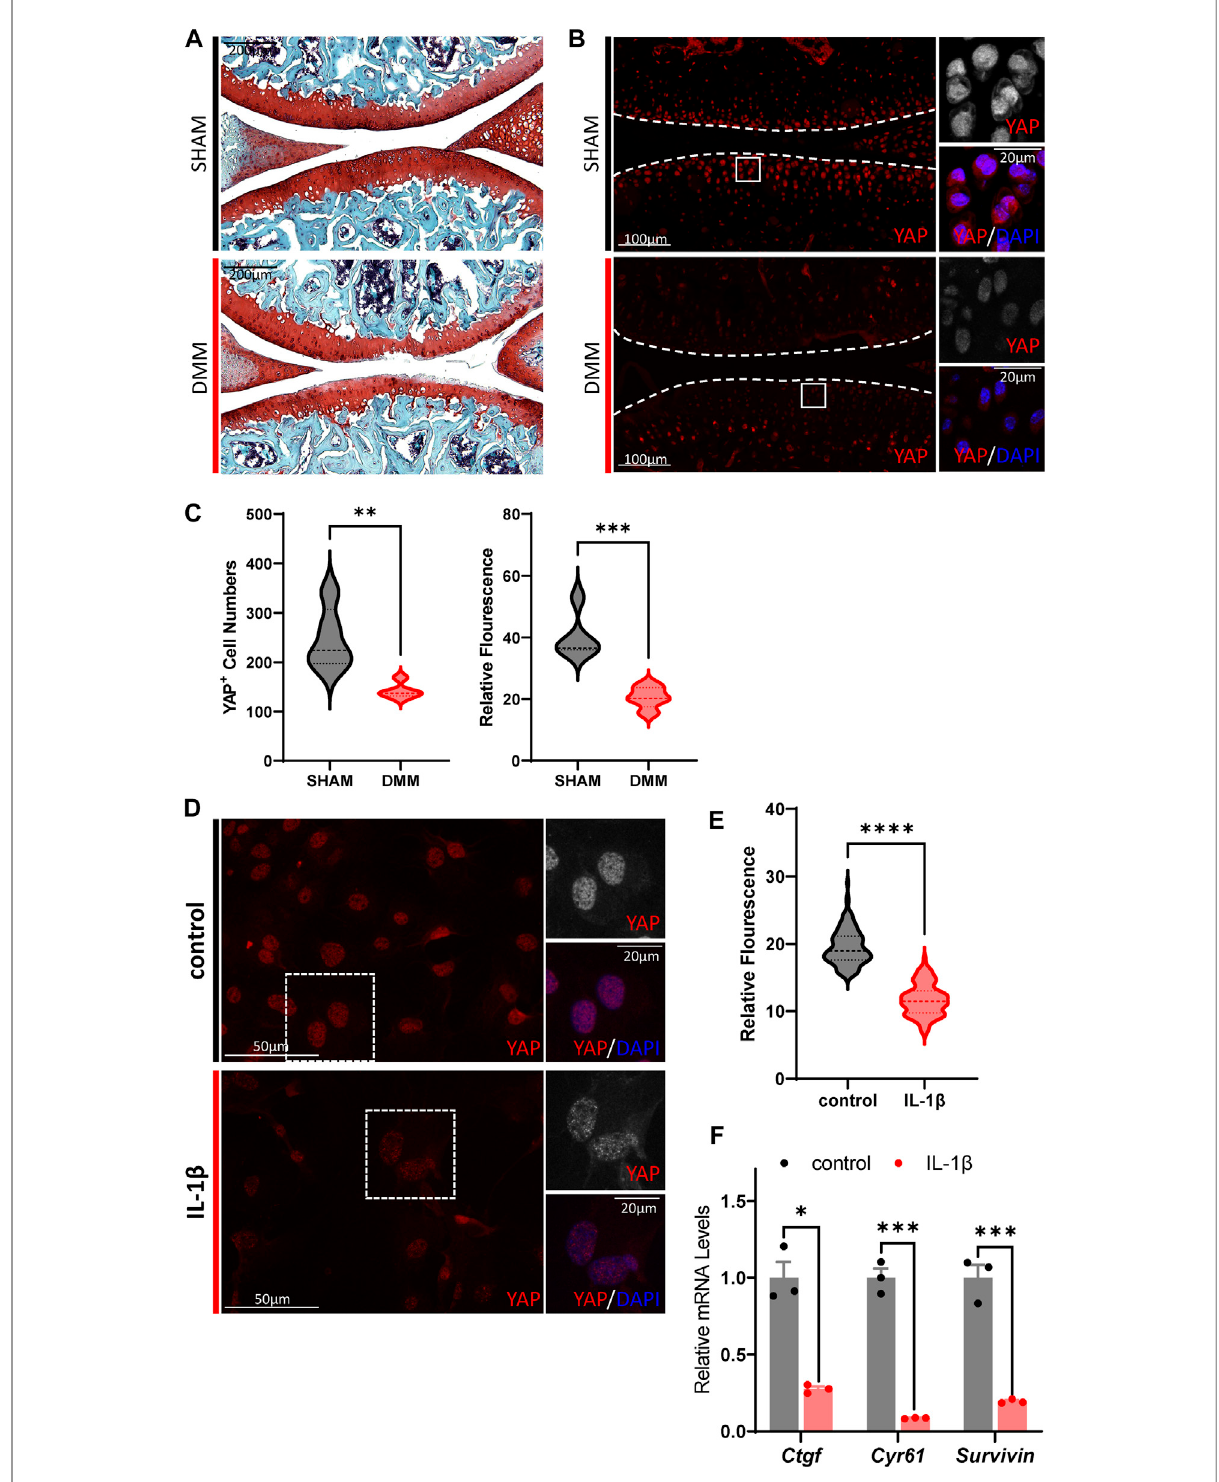
FIGURE 1 Hippo signaling is hyper-activated in OAchondrocytes. (A) Representative imagesof SafraninO/Fast Green staining of knee joint sections from wild-type mice which underwent sham or DMM surgery for 8 weeks. (B) Representative images of knee joint sections from wild-type mice which underwent sham or DMM surgery for 8 weeks. Sections were immunostained with antibody against YAP (red or gray) and DAPI (nuclei, blue). Panels on the right are high magni fi cations of boxed regions in the left panels. The dashed lines marked the edge of cartilage. (C) Statistical analysis of